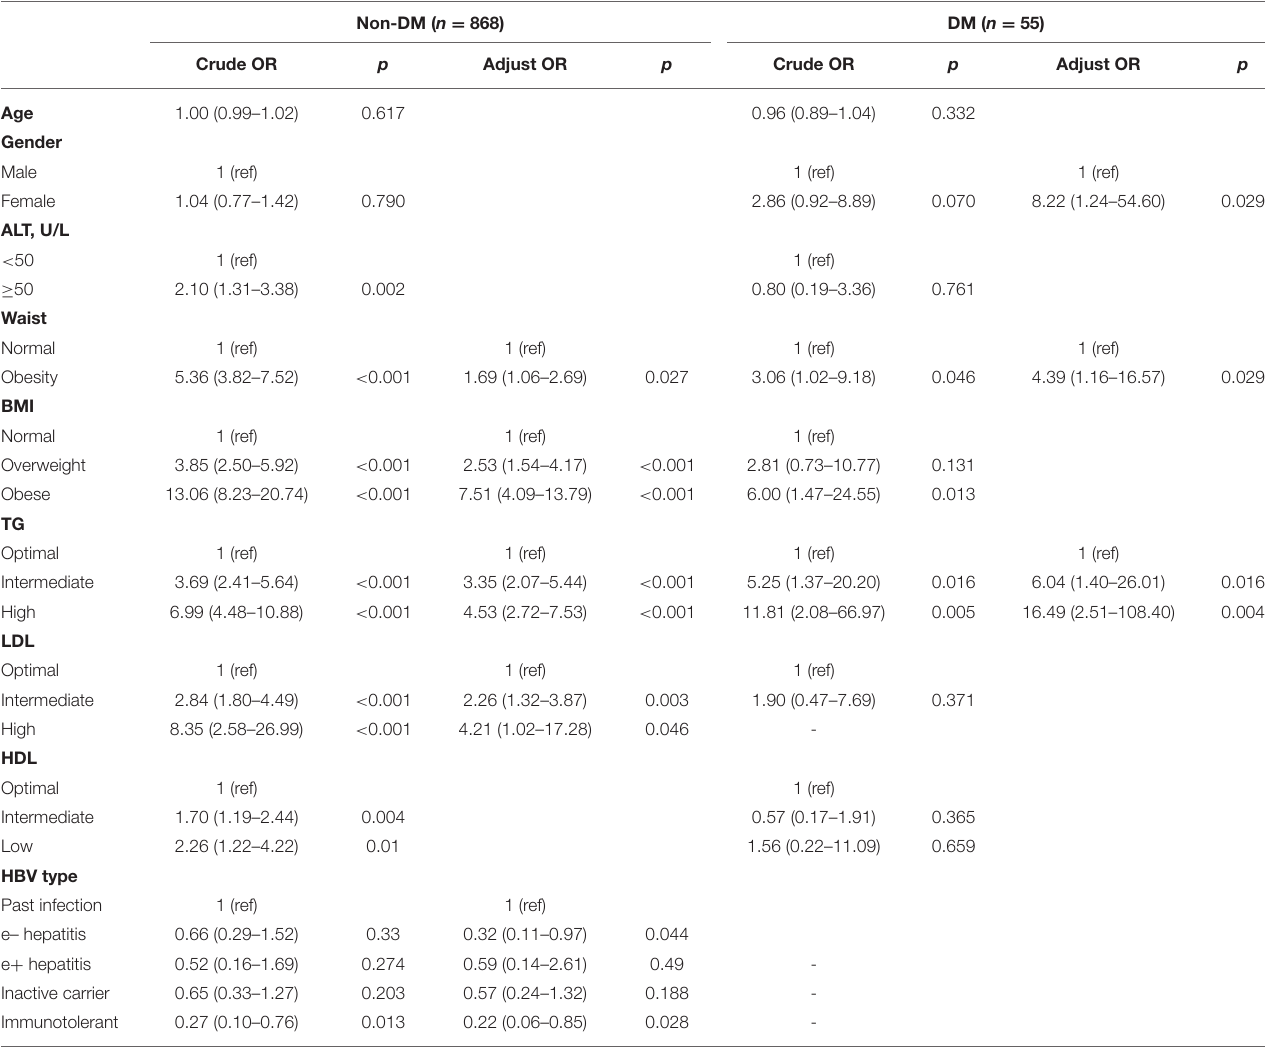
TABLE 2 | Effects of risk factors for NAFLD prevalence in diabetic and non-diabetic